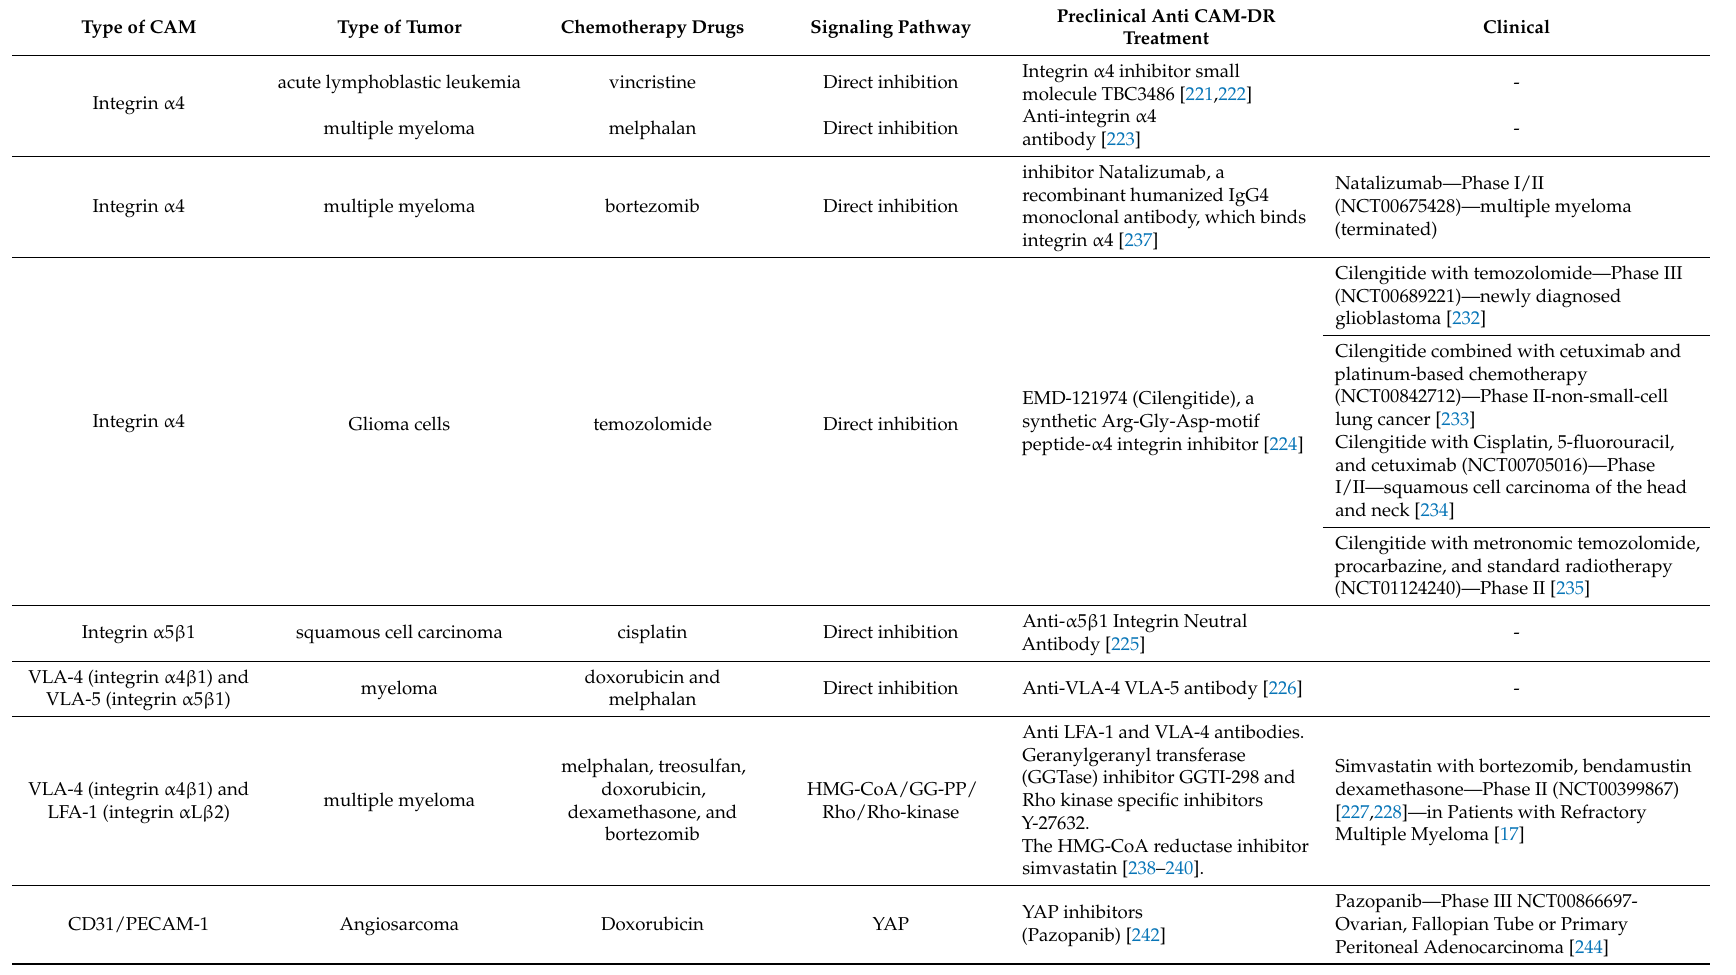
Table 2. Regulation of drug resistance related to cell adhesion